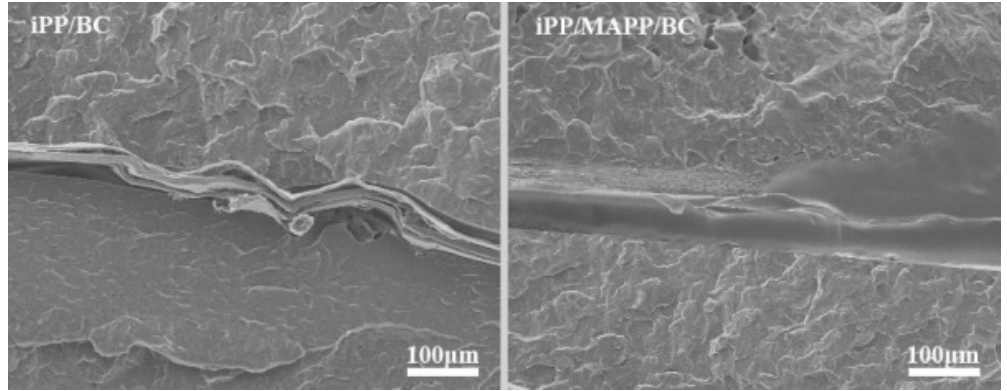
Figure 5. SEM photographs on the interface of the iPP/BC hamburger composite.